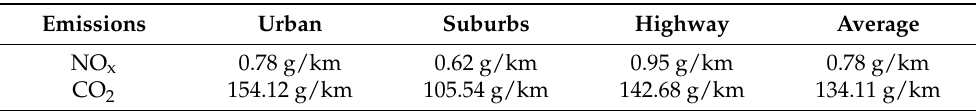
Table 4. Total emission